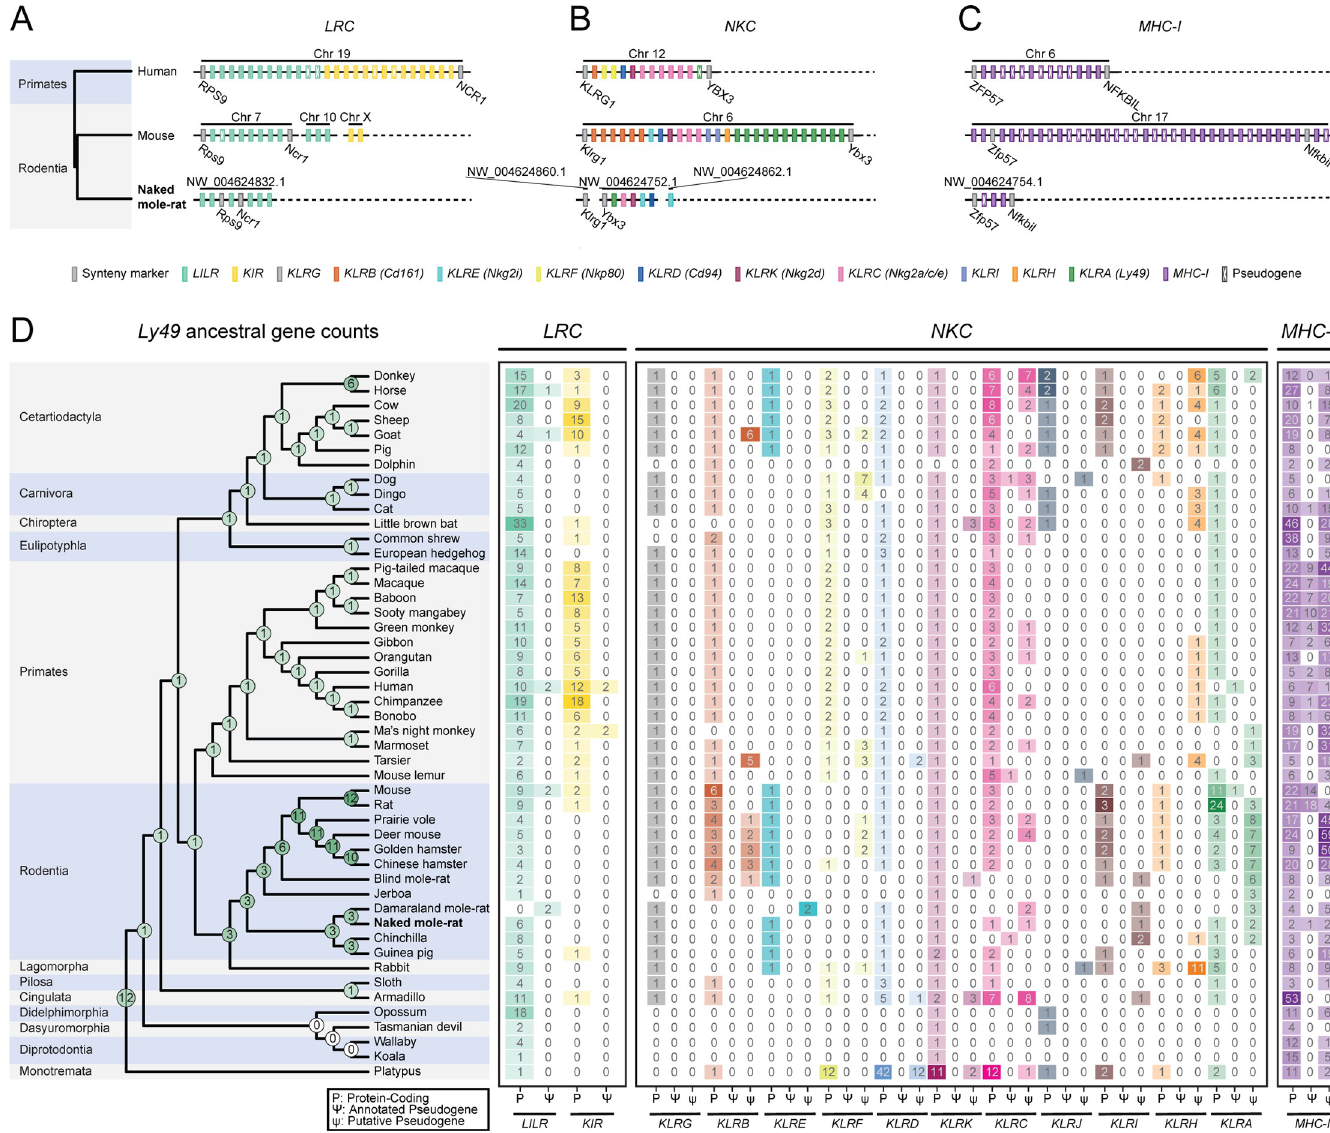
Fig 2. The NM-R genome lacks expanded NK cell receptor and MHC-I gene families. Schematic diagram of the linear arrangement of genes, in 5 0 -3 0 genomic orientation relative to the human genome, in the LRC ( A ), NKC ( B ), and MHC-I loci ( C ) of the human, mouse, and NM-R genomes. Boxes represent the genes encoding NK cell receptors and their ligands—MHC-I, which are known to control NK cell function, color-coded by family. Synteny markers (gray boxes) are genes that flank the human LRC , NKC , and MHC-I loci; ( D ) phyletic pattern showing the numbers of protein-coding genes (P) and annotated pseudogenes ( C ) (in the LRC , NKC , and MHC-I loci), as well as putative pseudogenes ( ψ ) (only in the NKC and MHC-I loci) across 48 mammalian genomes (Materials and methods). Overlaid on the phylogeny are the maximum parsimony–reconstructed ancestral numbers of the Ly49 ( KLRA ) gene family. Color shades in both the phyletic pattern and ancestral Ly49 counts correspond to the numbers of genes. Ancestral Ly49 counts are represented as pie charts in which the slice sizes correspond to the probability of each count. In all phylogenies, order names are indicated and faceted by the gray and blue background colors. Chr, chromosome; LRC , leukocyte receptor complex; MHC-I , major histocompatibility complex class I; NK, natural killer; NKC , natural killer cell receptor complex; NM-R, naked mole-rat.